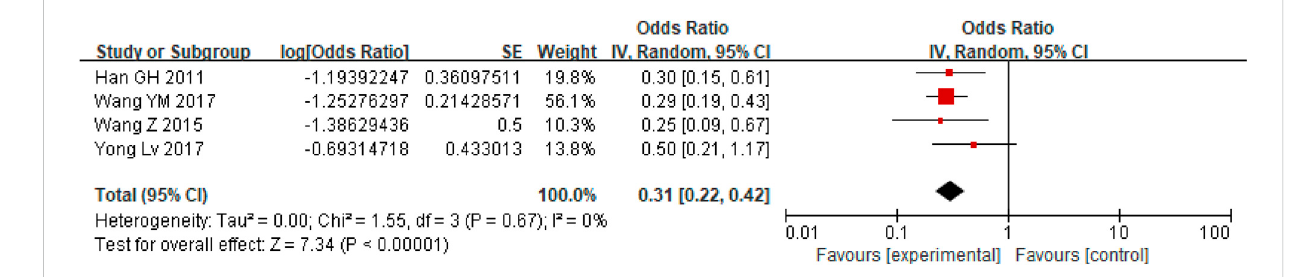
FIGURE 6 The occurrence of death.